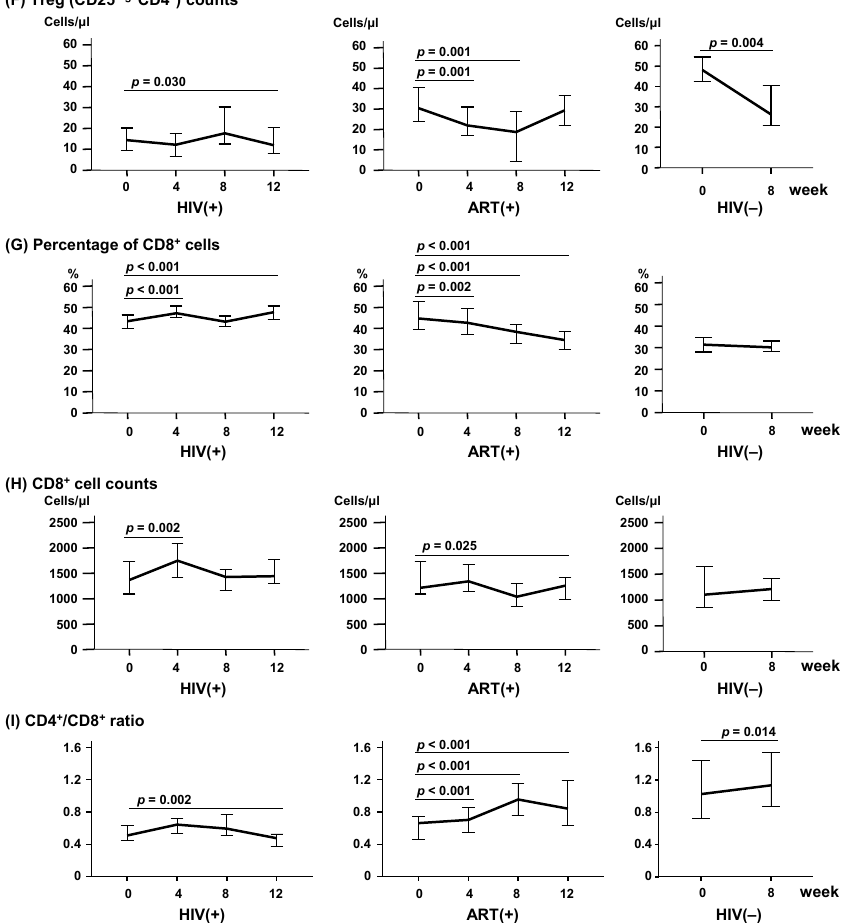
Figure 2. Changes of the CD4 + cell and subset counts and CD8 + cell counts after LcS ingestion in the HIV(+) ( n = 31), ART(+) ( n = 29), and HIV( − ) ( n = 20) groups. ( A ) CD4 + cell percentages among lymphocytes; ( B ) CD4 + cell counts; ( C ) Type 1 helper T cell, CXCR3 + CCR6 − CD4 + (Th1) counts; ( D ) Th2 (CXCR3 − CCR6 − CD4 + ) counts; ( E ) Th17 (CXCR3 − CCR6 + CD4 + ) counts; ( F ) Treg (CD25 high CD4 + ) counts; ( G ) CD8 + cell percentages among lymphocytes; ( H ) CD8 + cell counts; ( I ) CD4/CD8 ratio. Bars represent the median and 95% CI for each group. The p values show the comparison of weeks 4, 8, and 12 to week